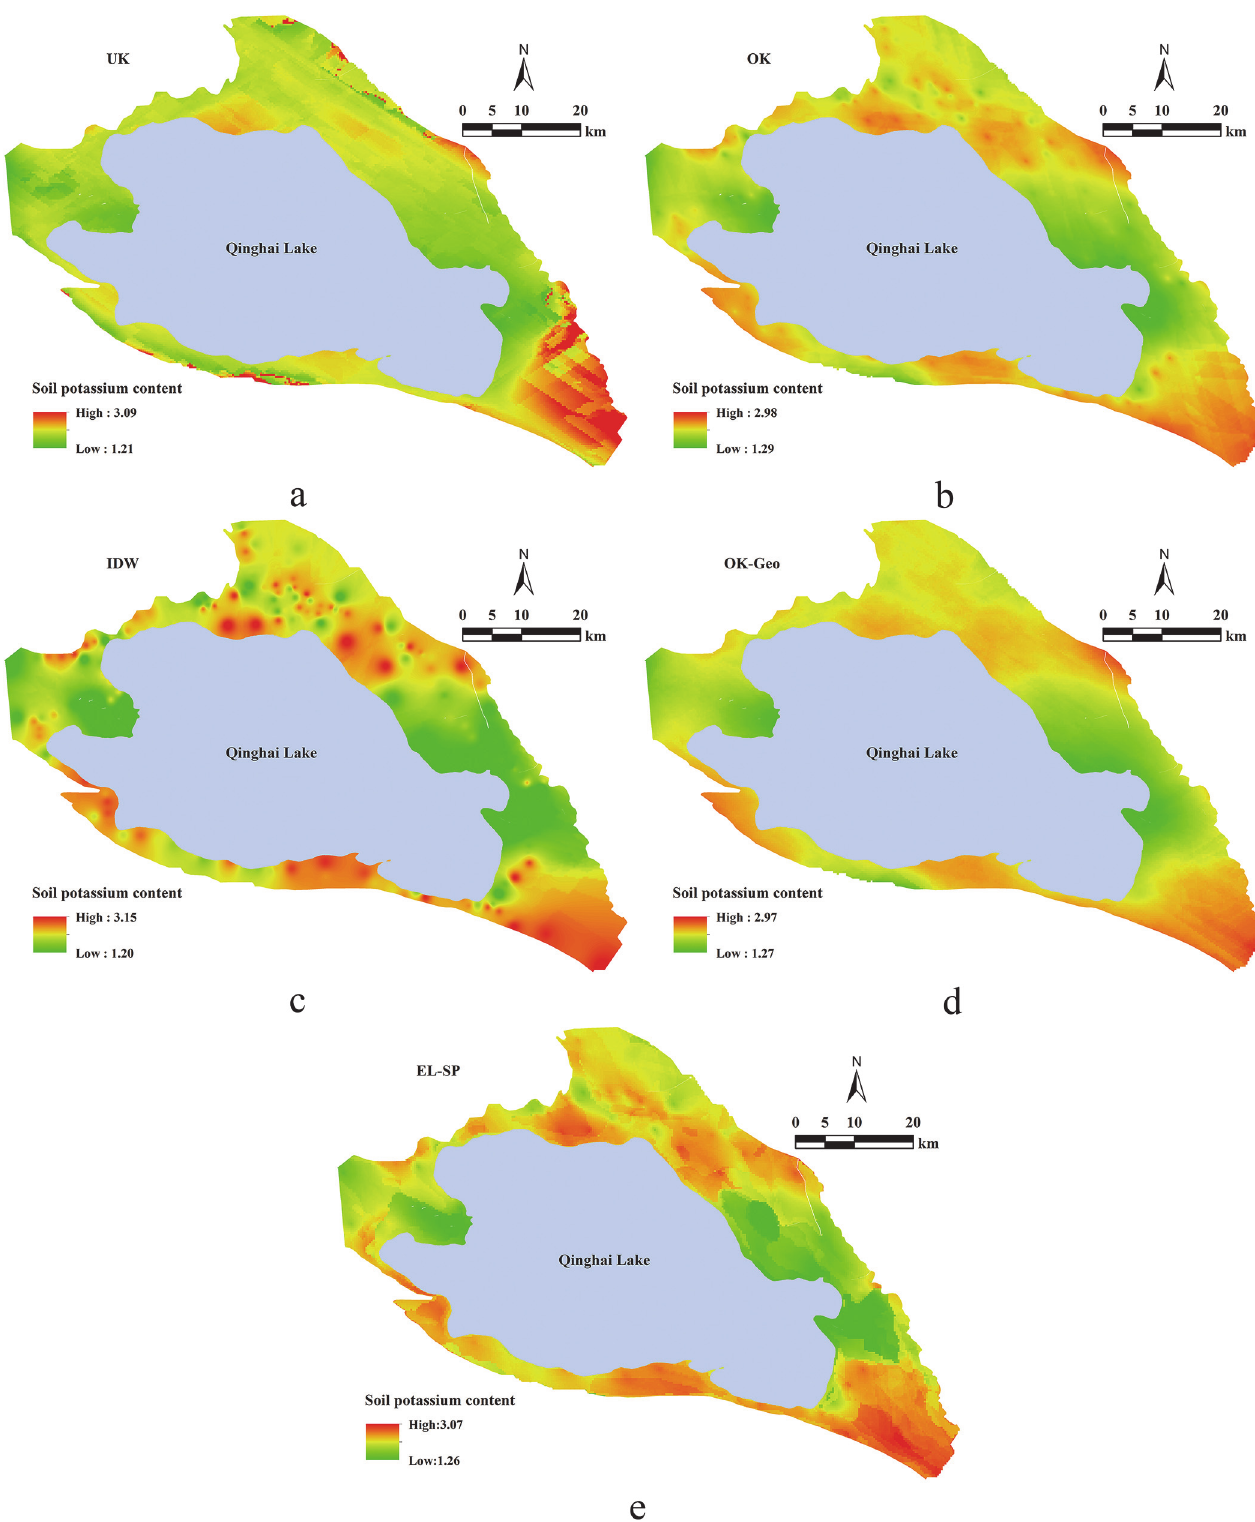
Fig 3. Comparisons of the soil potassium content maps interpolated by (a) UK, (b) OK, (c) IDW, (d) OK-Geo, and (e) EL-SP.